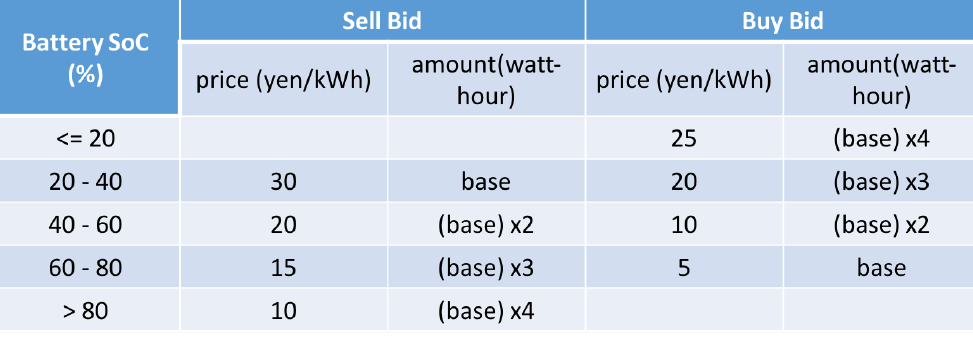
Figure 3. Bidding prices and amounts for State of Charge (SoC)-based bidding